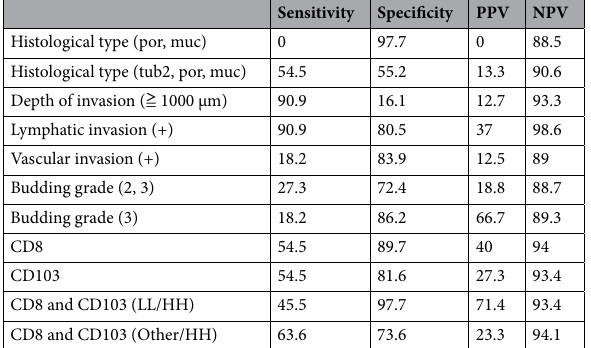
Table 4. Sensitivity, specificity, positive predictive value (PPV), and negative predictive value (NPV) of risk factors. CD cluster of differentiation, LL numbers of both CD103 + and CD8 + TILs were low, HH numbers of both CD8 + and CD103 + TILs were